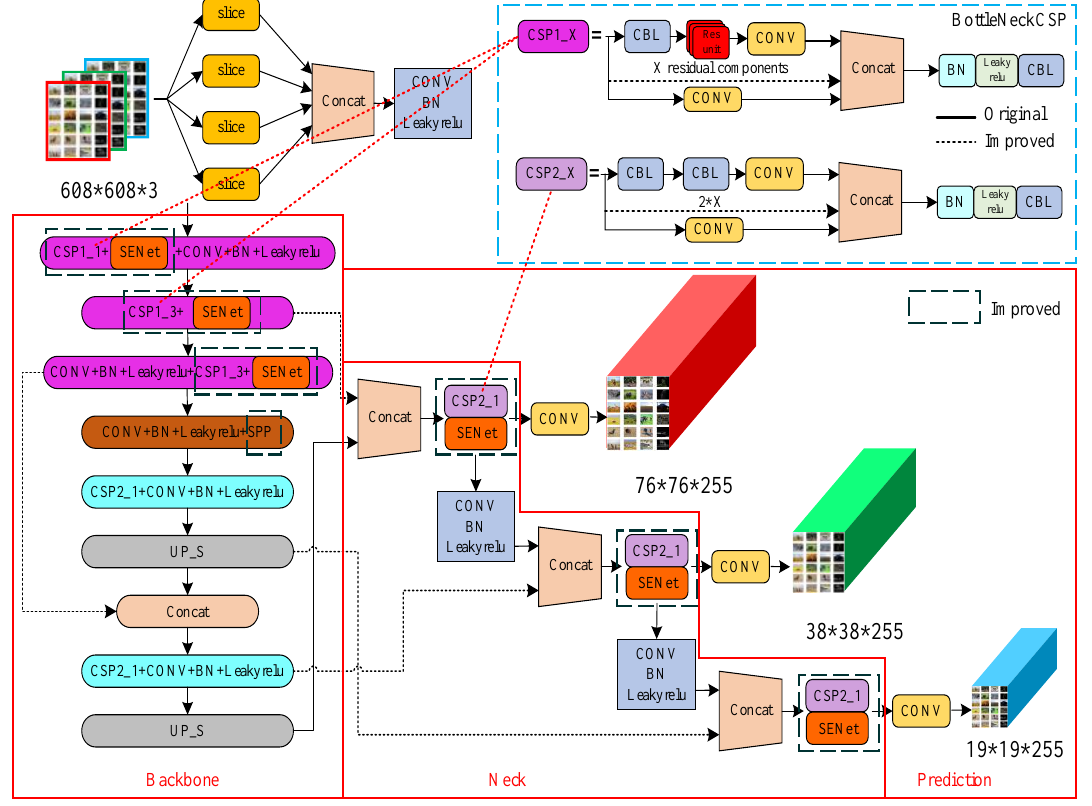
Figure 2. The network structure of improved YOLOv5s.